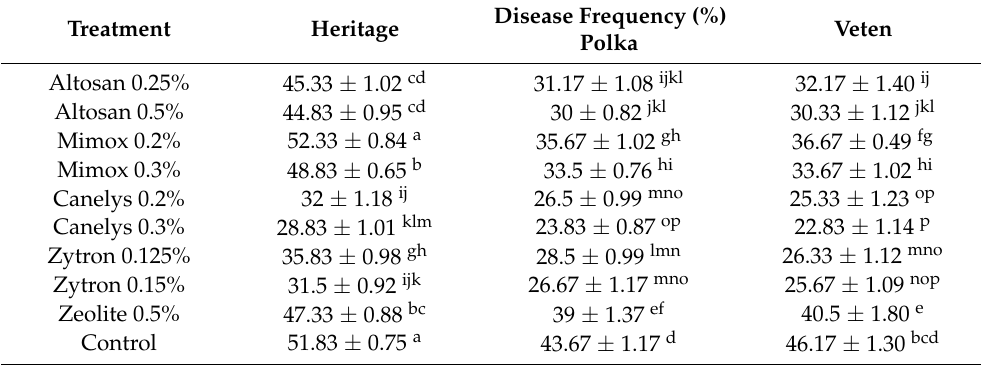
Note: Values presented in the table are the means ± standard error. Means followed by different letters indicate differences at p < 0.05 according to LSD test applied to all varieties from each species. Variants tested: V1-Altosan 0.25%; V2-Altosan 0.5%; V3-Mimox 0.2%; V4-Mimox 0.3%; V5-Canelys 0.2%; V6-Canelys 0.3%; V7-Zytron 0.125%; V8-Zytron 0.15%; 9-Zeolite 0.5%; V10-Control. A full description of treatment recipes is provided in Table 12.